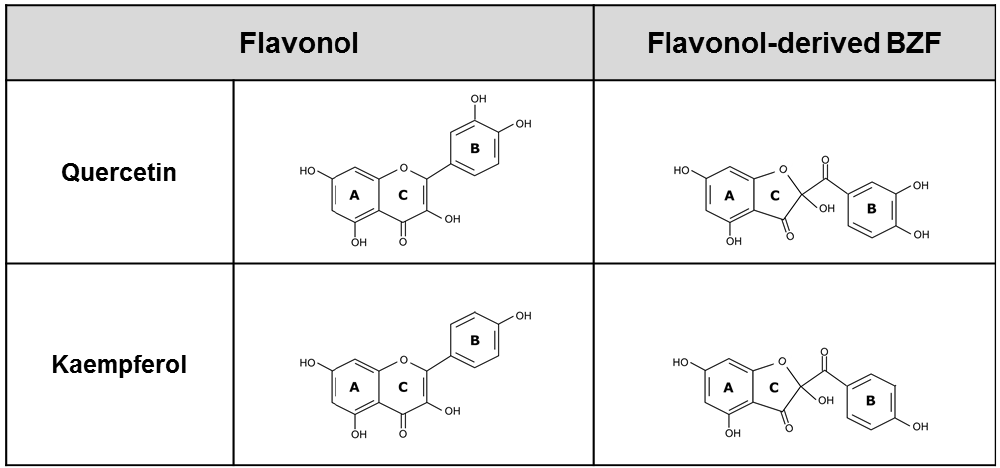
Figure 1. Chemical structures of the flavonols quercetin (3,3 ′ ,4 ′ ,5,7-pentahydroxyflavone) and kaempferol (3,4 ′ ,5,7-tetrahydroxyflavone), and their respective benzofuranones: quercetin-derived BZF (2-(3,4-dihydroxybenzoyl)-2,4,6-trihydroxy-3(2H)-benzofuranone), and kaempferol-derived BZF (2-(4-hydroxybenzoyl)-2,4,6-trihydroxy-3(2H)-benzofuranone).